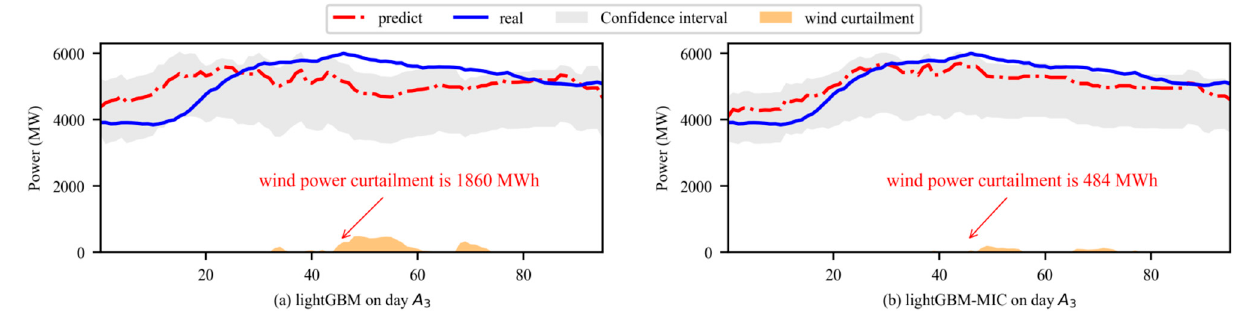
Figure 10. Wind power prediction interval of typical day A 3 .